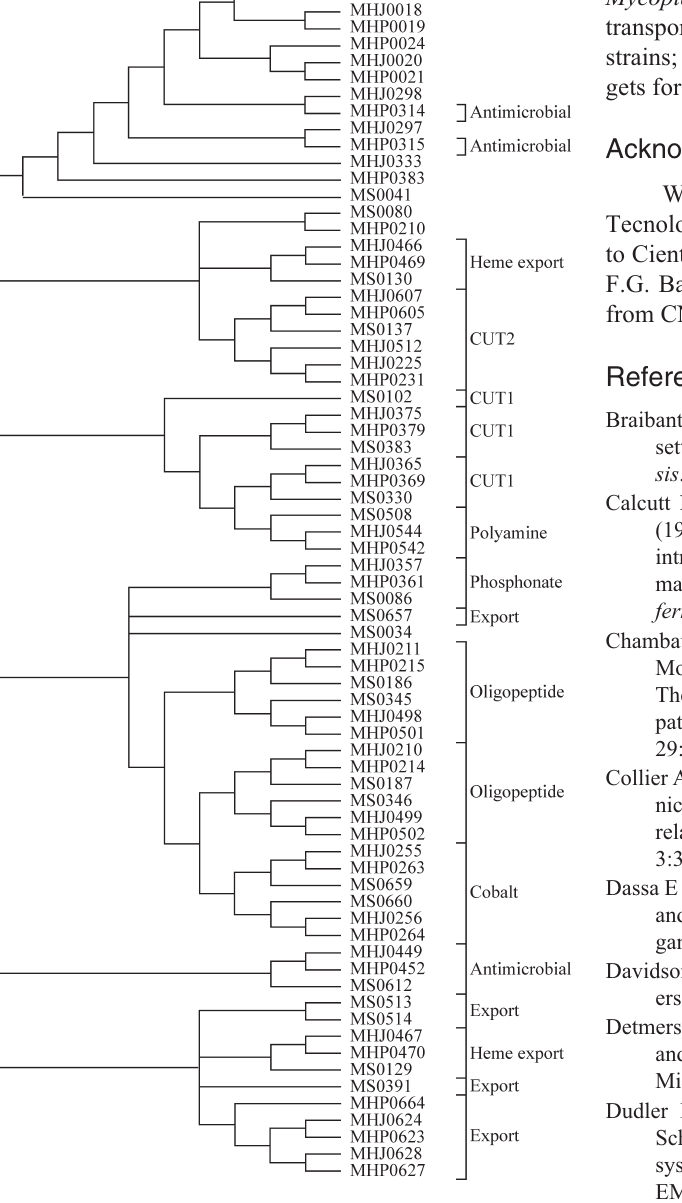
Figure2 -Phylogenetictreereconstructedwiththenucleotidesequenceof ATP-binding domains from the three strains of this study. CUT1 and CUT2 : carbohydrate uptake transporters; Export : general or unspecified exporter; Antimicrobial : antibacterial compound exporters; Heme export : Heme compound exporters; Unspecified : undetermined importers; others represent specific elements